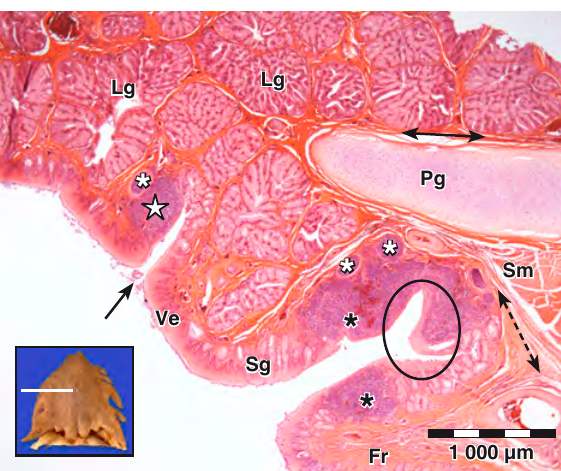
1 000 µm FIG. 9 Cross­section of the lateral tongue body and papillae base demonstrating large, simple branched tubular glands (Lg). Note the simple tubular glands (Sg) and diffuse (black *) and nodular (white *) lymphoid tissue exclusively present on the tongue ventrum. Para glos­ sum (Pg), skeletal muscle (Sm), ventral epithelium (Ve), mucosal folds of ventrum at frenular junction (en­ circled), compressed submucosa surrounding the pa­ raglossum (double­headed arrow) and skeletal muscle (dotted double­headed arrow), frenulum (Fr), large gland opening (arrow) with lymphoid tissue invading the glandular tissue (white star)